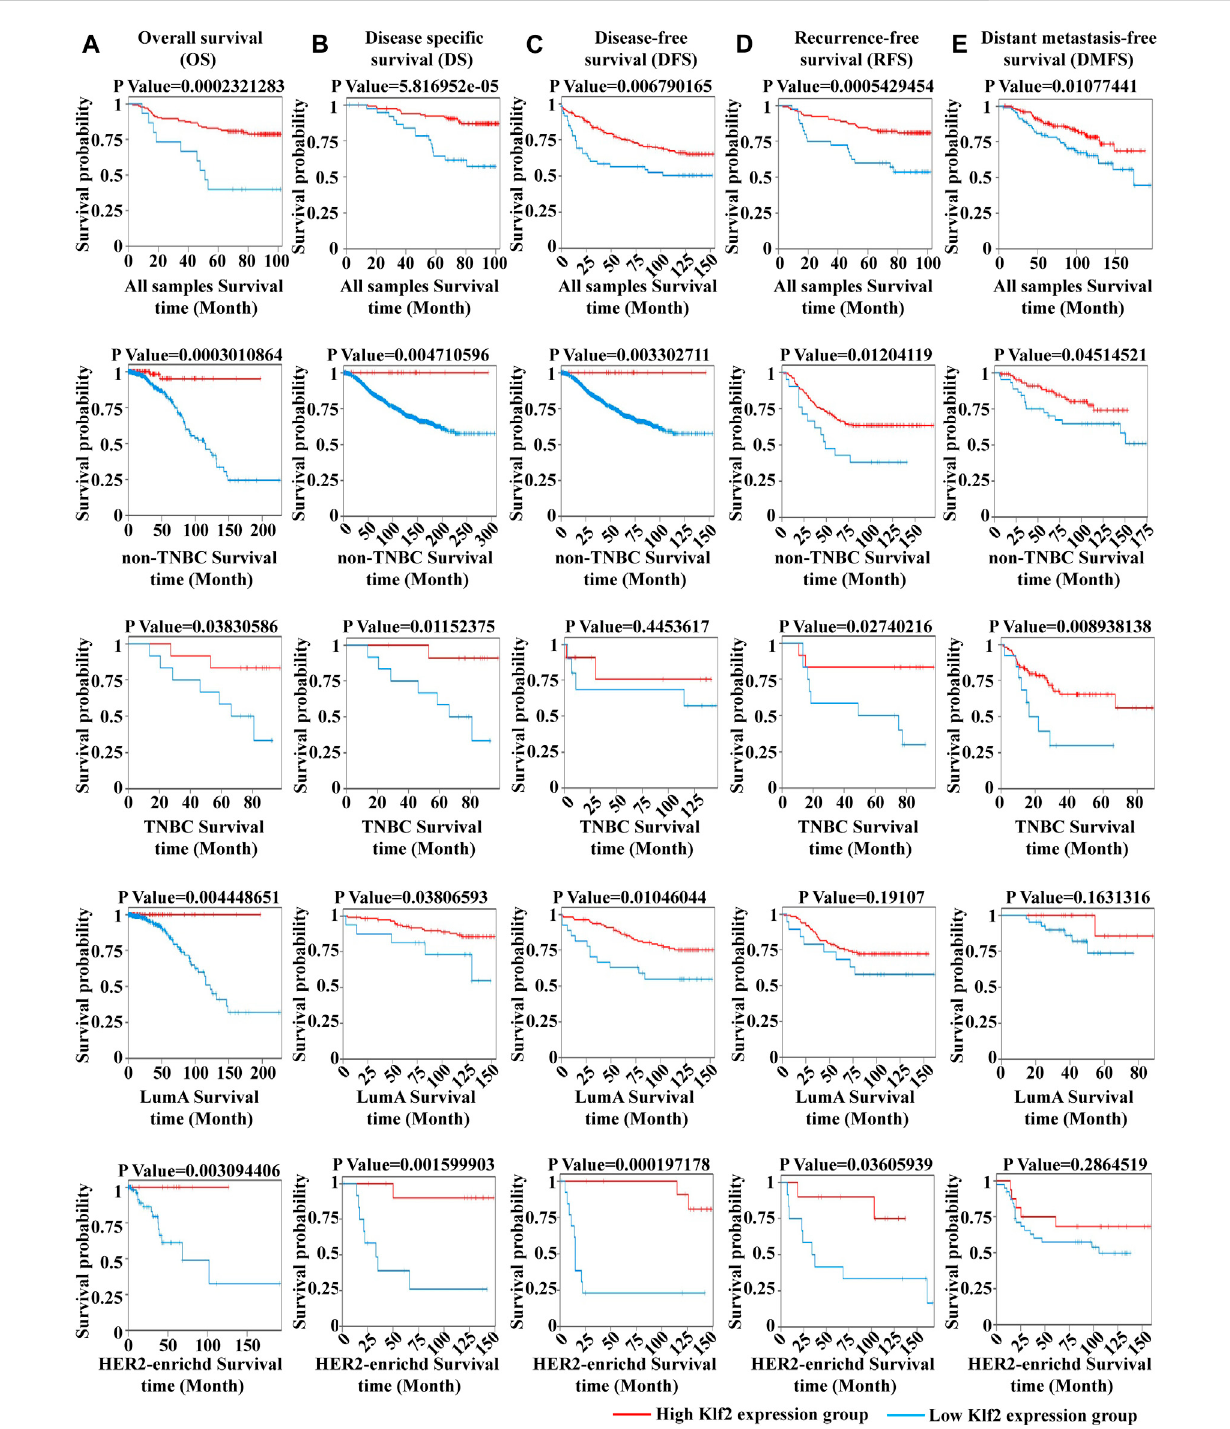
FIGURE 3 The impact of KLF2 on the survival probability of breast cancer patients. Overall survival (OS) (A) , disease speci fi c survival (DS) (B) , disease-free survival (DFS) (C) , recurrence-free survival (RFS) (D) , and distant metastasis-free survival (DMFS) (E) .